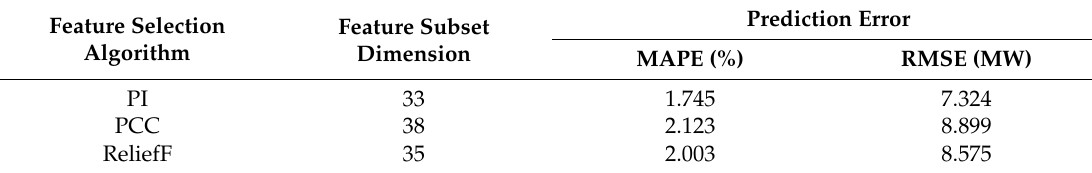
Table 7. Comparison of three feature selection algorithms when day-ahead prediction is